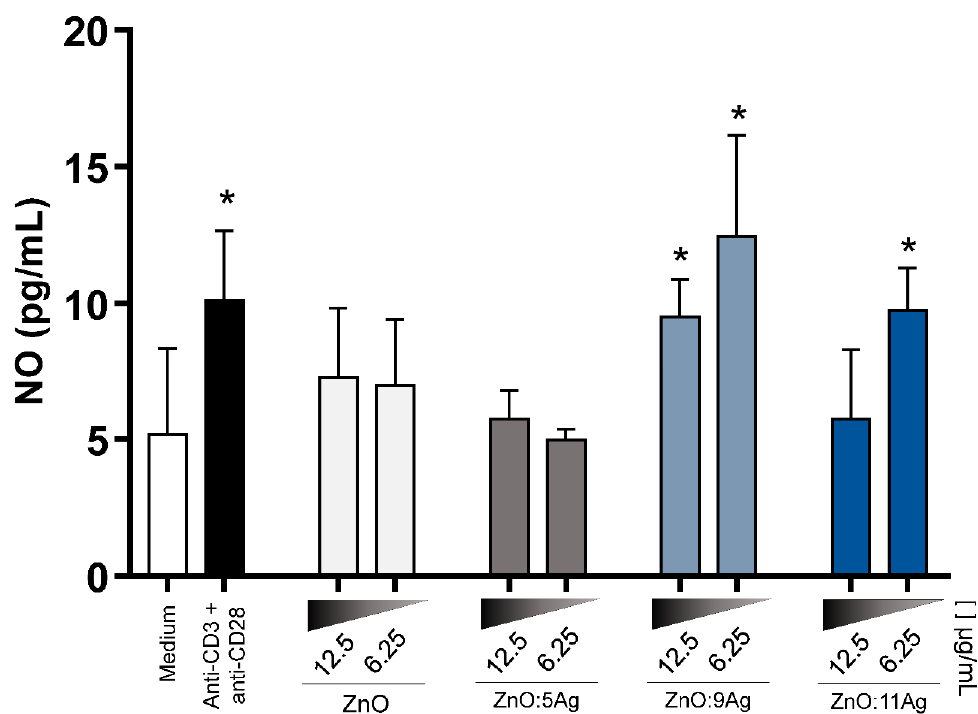
Figure 8. ZnO:9Ag and ZnO:11Ag NCPs increased NO production. NO production was evaluated by the modified Griess method in the supernatant of PBMC cultures treated with different nanoformulations at doses of 12.5 µ g/mL and 6.25 µ g/mL for 72 h. The results are expressed as the mean ± SEM in picograms per milliliter (pg/mL). The Mann–Whitney test was applied, and values of p < 0.05 (*) were considered significant when compared to cell culture without treatment (medium). Cells without treatment (medium) and cells treated with anti-CD3 and anti-CD28 stimuli were used as negative and positive controls, respectively. NO production was increased in cultured cells treated with ZnO:9Ag and ZnO:11Ag NCPs, especially at the lowest dose.